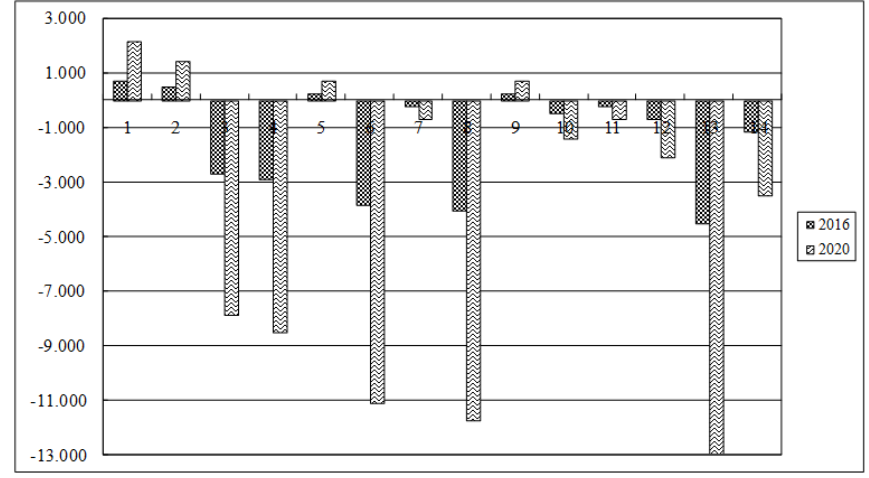
Figure 2. Reduction percentage for designed scenarios in year 2016 and 2020 (%).